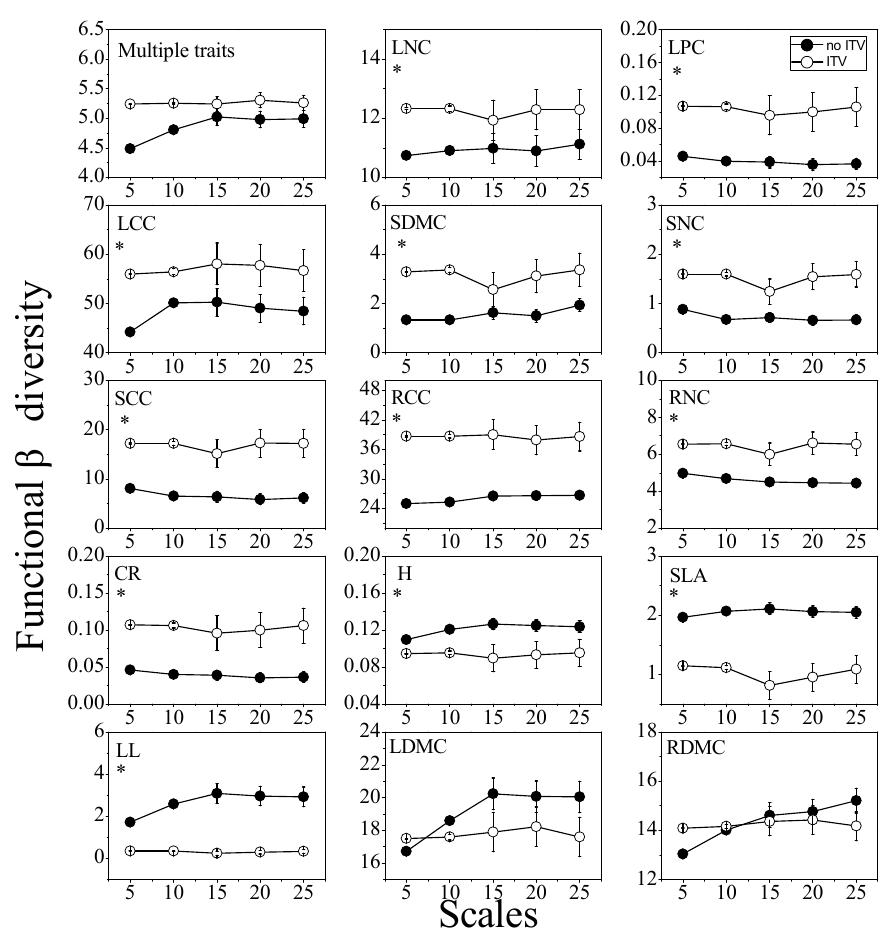
Figure 3. Influence of spatial scales and intraspecific trait variation (ITV) on the functional beta diversity (mean ± SE). There are five spatial settings: 5 m × 5 m, 10 m × 10 m, 15 m × 15 m, 20 m × 20 m, 25 m × 25 m. Functional beta diversity of multiple traits for different spatial scales is shown in the top left panel. Functional beta diversity of single traits for different spatial scales are shown in their respective panels (including leaf carbon content (LCC), leaf dry matter content (LDMC), leaf phosphorus content (LPC), leaf nitrogen content (LNC), stem dry matter content (SDMC), stem carbon content (SCC), stem carbon content (SNC), root carbon content (RCC), root nitrogen content (RNC), root dry matter content (RDMC), canopy range (CR), leaf length (LL), specific leaf area (SLA), and height (H)). Hollow black point: including ITV; solid black point: not including ITV, * means p < 0.05.